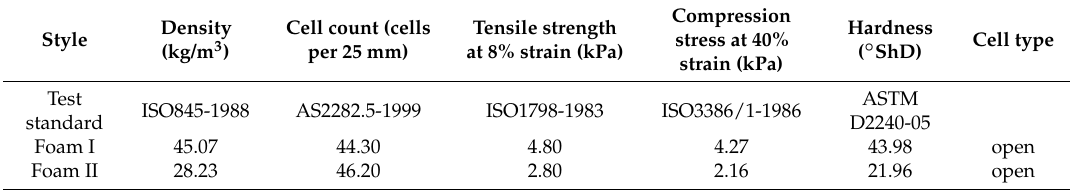
Table 1. Specifications and physical properties of the 2 polyurethane (PU) foam material samples.